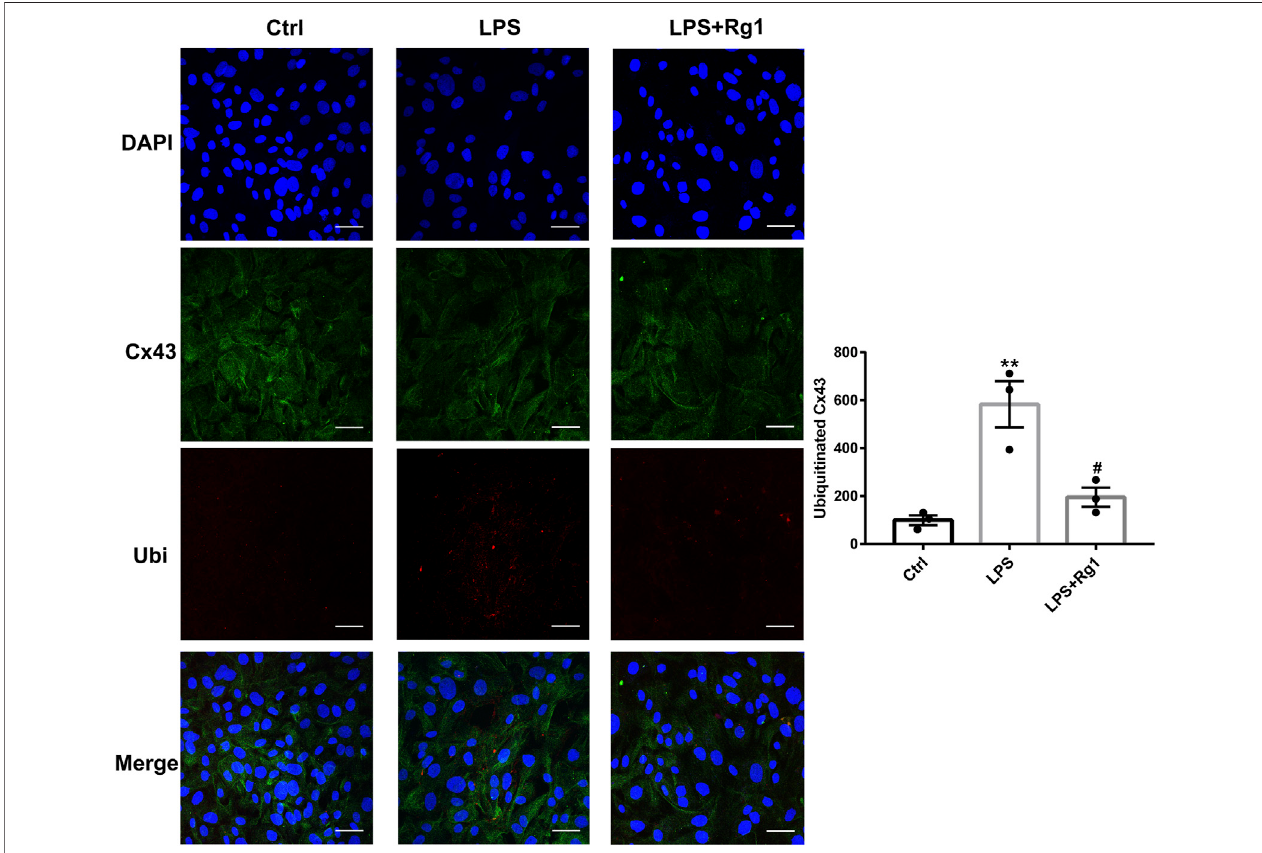
FIGURE 9 | Rg1 reduces ubiquitinated Cx43 in LPS-treated glial cells. The confocal microscopy images showed double-stained with antibodies against Cx43 (green)and ubiquitin (red). Nucleiwere labeled withblue. Scalebar (cid:1) 150 μ m. n (cid:1) 3. ** p < 0.01, compared with theCtrl group; # p < 0.05, compared withthe LPSgroup.